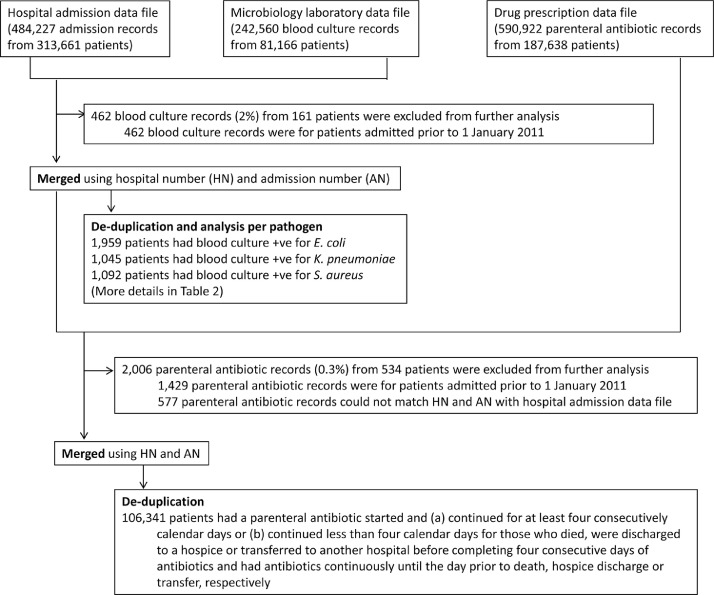
Study data flow diagram. * A blood culture episode was defined as all blood culture specimens collected within two calendar days beginning when a blood culture specimen was collected.